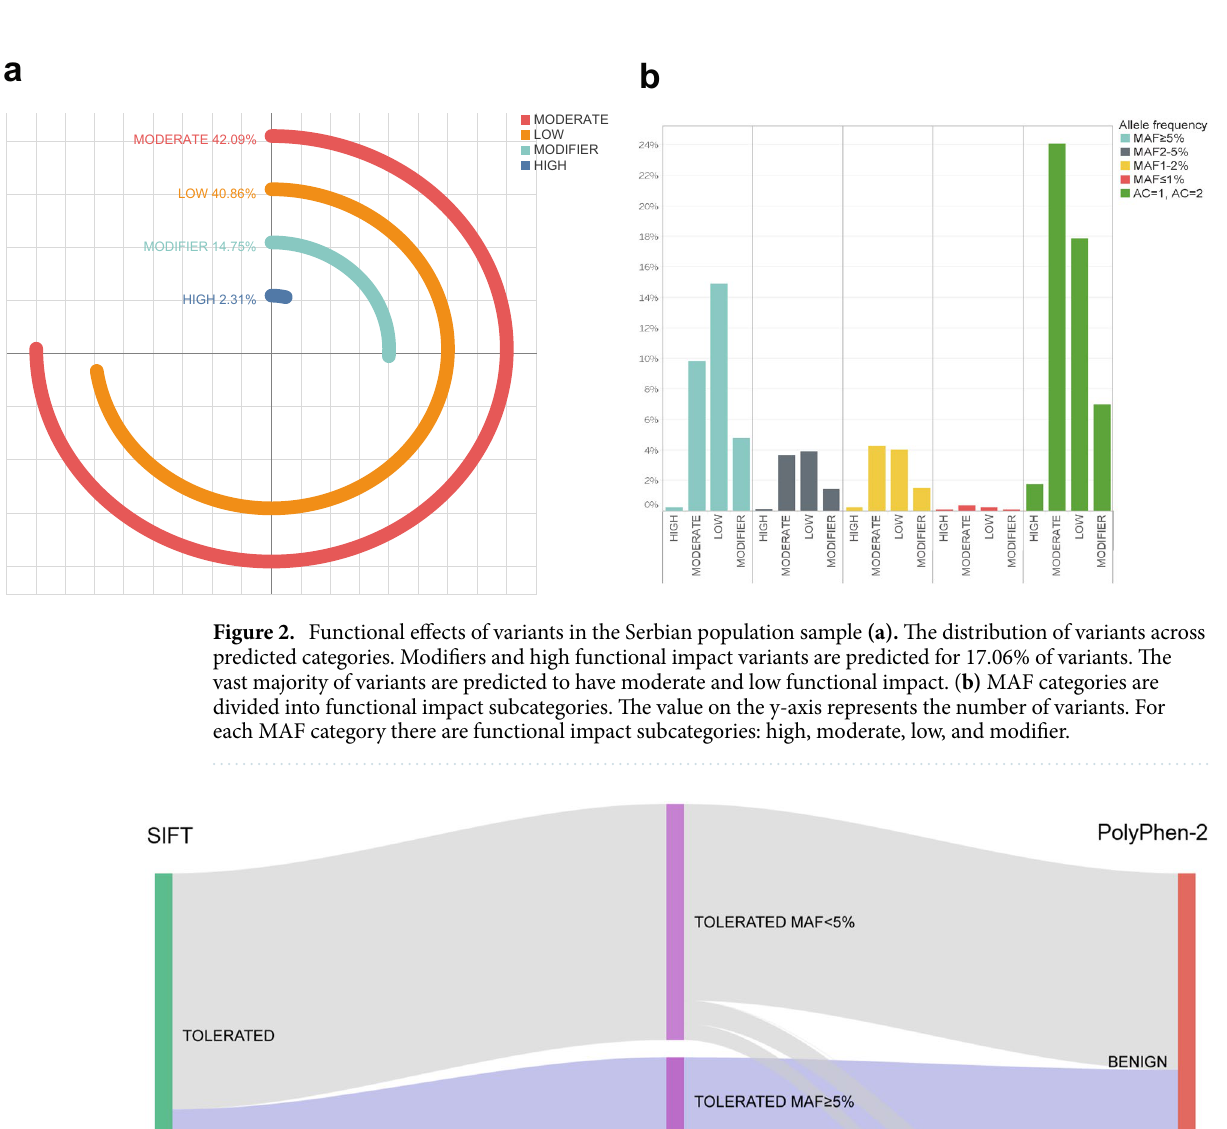
v5.2.2 29 and PolyPhen-2 v2.2.2 30 . Pathogenicity prediction using SIFT was obtained for 40.33% (19,089) of the